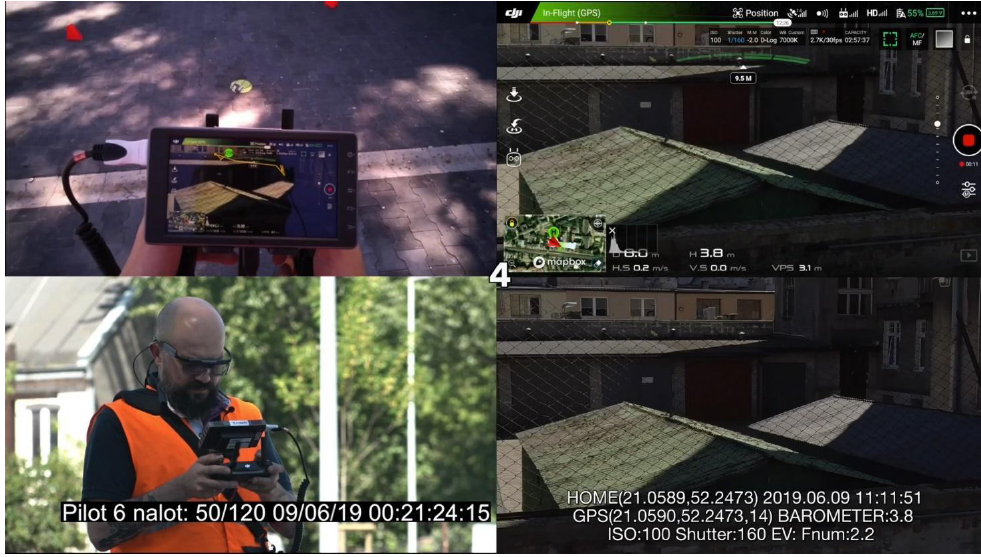
Figure 3. Research footage of the authors; image from eye tracker ( upper left ), image from drone ( upper right ), pilot information ( lower left ), recording information ( lower right ); Source: own